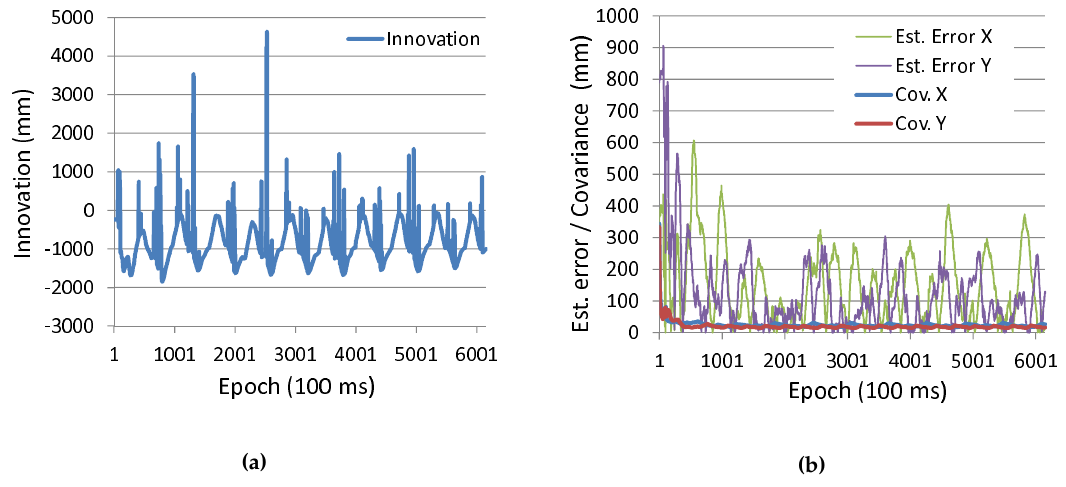
Figure 12. Time series of EKF parameters of robot localization. ( a ) Innovation sequence; ( b ) Estimation error and error